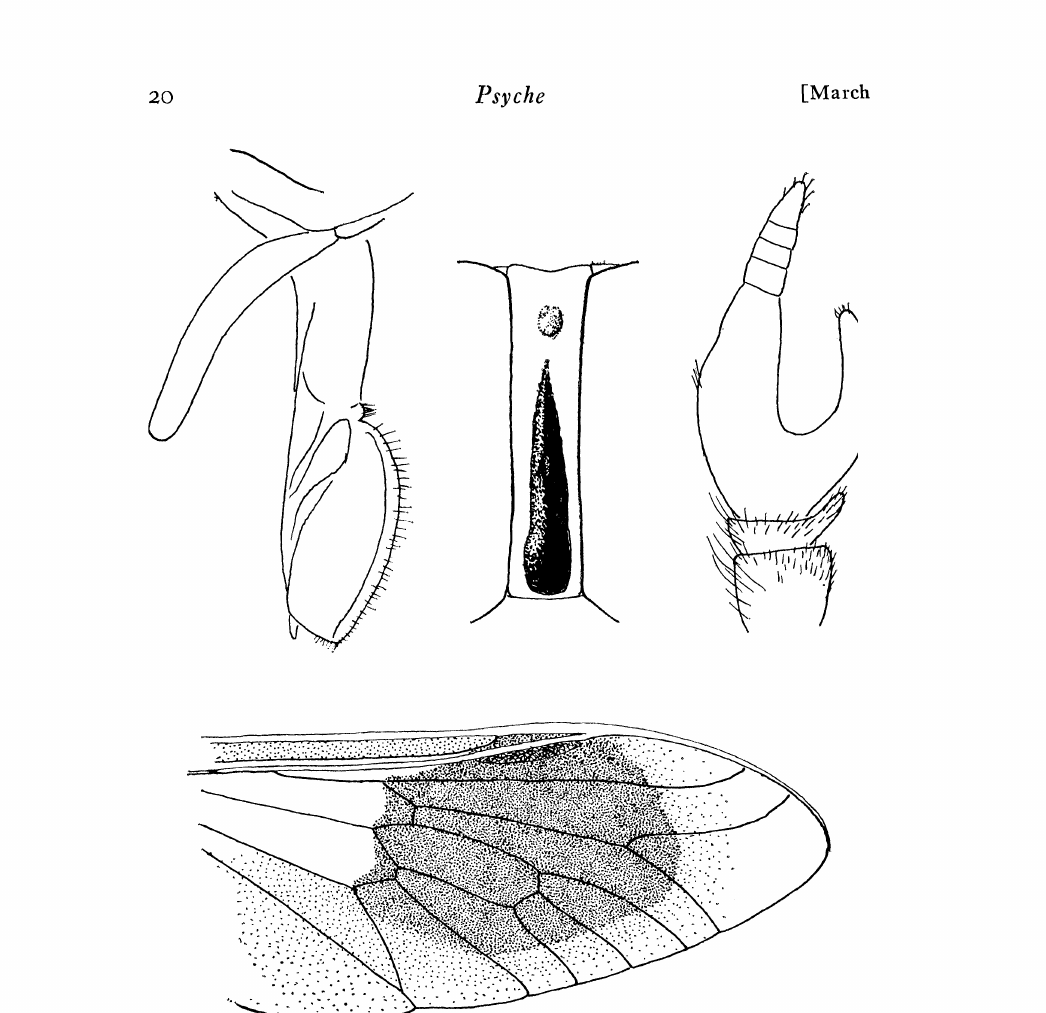
ruescens (Fab.), palpi and proboscis, frons, an- Fig. 1. CaCachlorops tenna and wing. Proboscis and frons are to same scale, antenna at twice this magnification and wing about half magnification of frons.